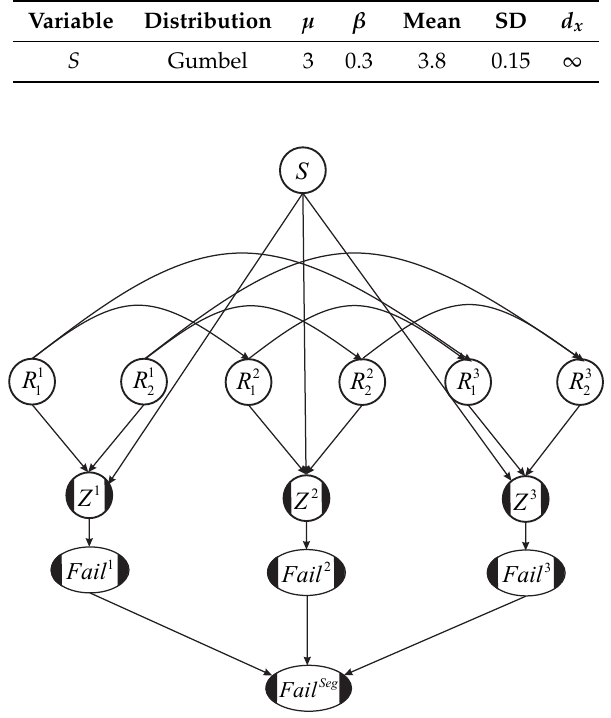
Figure 10. BN for a segment, shown here for three cross sections, where cross-sectional failure is defined by the limit state function in Equation